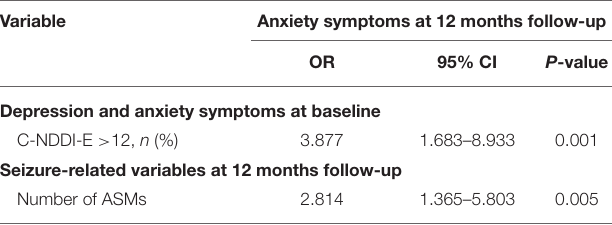
TABLE 3 | Comparison of patient characteristics between patients with and without anxiety symptoms at 12 months. Variable